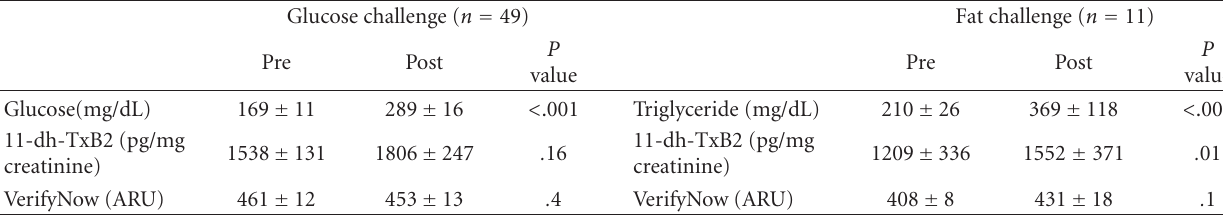
Table 2: Response to glucose or fat challenge.